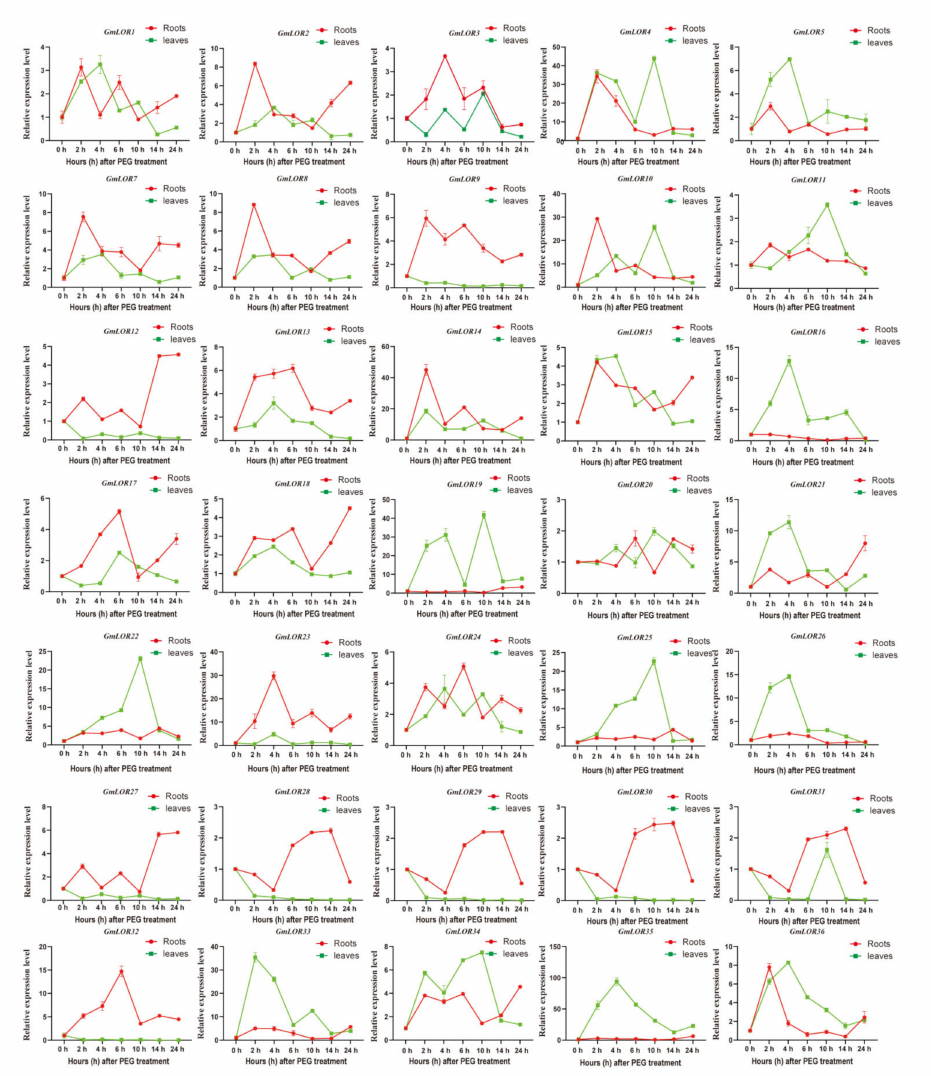
Figure 7. Relative expression levels of GmLORs in response to PEG stress. The soybean cultivar, Tianlong 1, was grown hydroponically, cultured for two weeks, and then exposed to 25% PEG treatment. The relative expression levels of 36 GmLOR genes at 2, 4, 6, 10, 14, and 24 h were determined by qRT-PCR in comparison with 0 h (the expression was set as “1”). The soybean ACT11 gene was used as the internal control. The data represented the mean ± SD of three independent biological